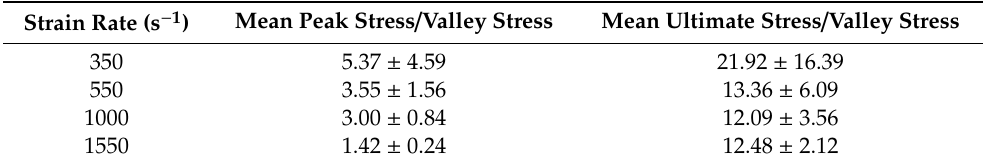
Table 2. Ratio of peak stress / valley stress and ratio of ultimate stress / valley stress shows an overall decreasing trend along with the increase of the strain rate. ( n = 4).